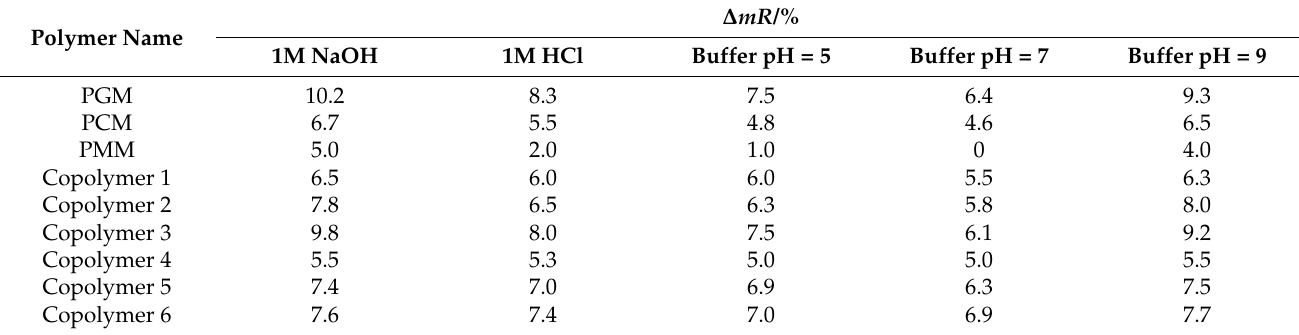
Table 6. Percentage change in mass loss ( ∆ mR ) for samples conditioned at 50 ◦ C (series 1).